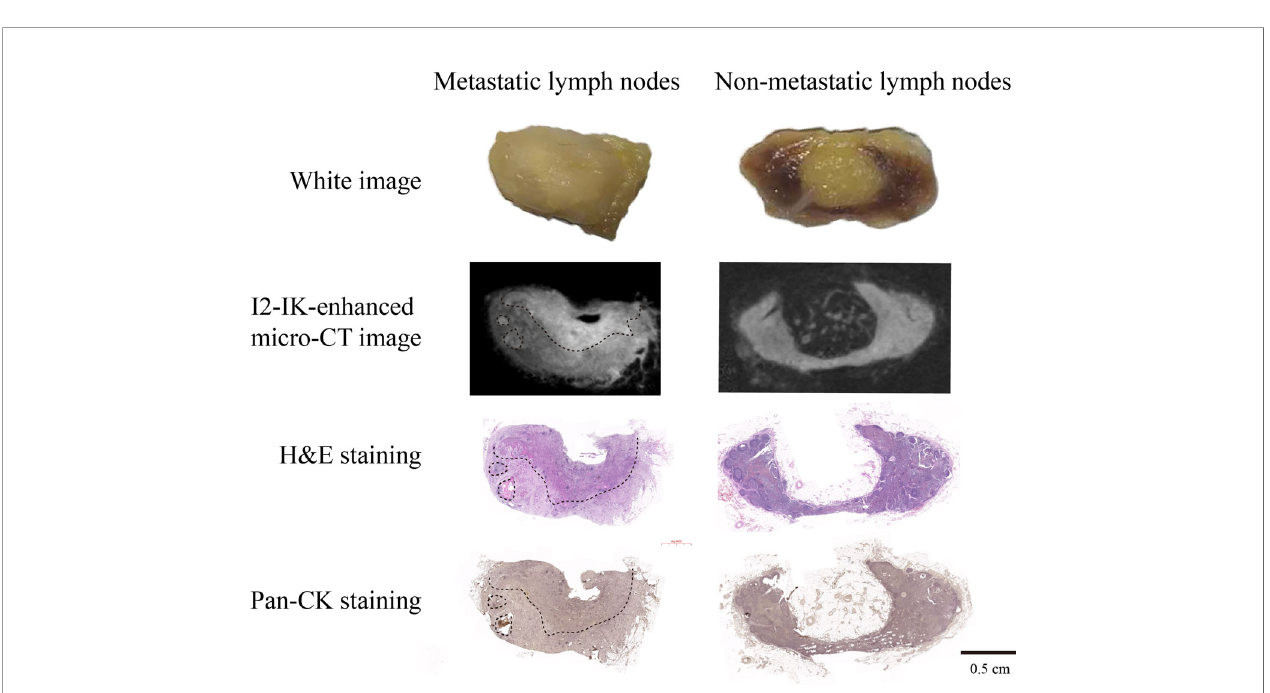
FIGURE 5 | I 2 -IK-enhanced micro-CT imaging after paraf fi n embedding for clinical OSCC regional metastatic LNs. From the micro-CT image and pathological image, we found that I 2 -IK-enhanced micro-CT imaging could still clearly locate the metastatic foci in LNs. Moreover, the overstaining caused by high concentration I 2 -IK was disappeared after the paraf fi n-embedding